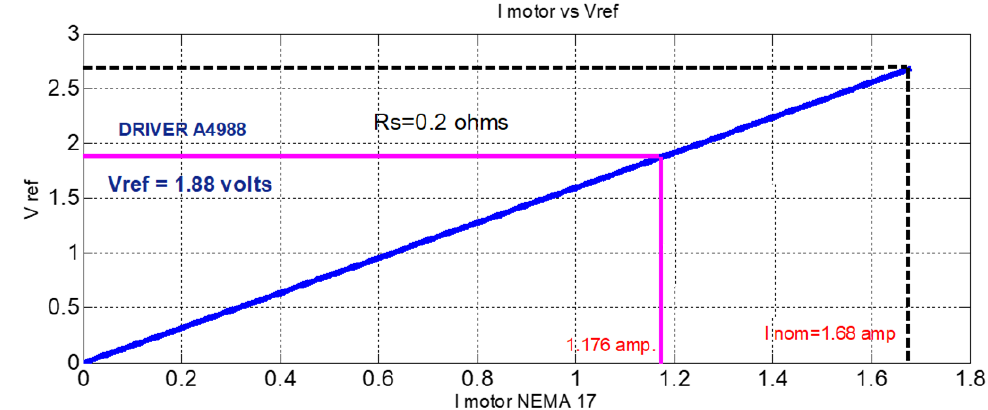
Figure 10. V ref setting values with R s = 0.2 ohms with respect to motor current. Table 5. V ref of the A4988 drivers.